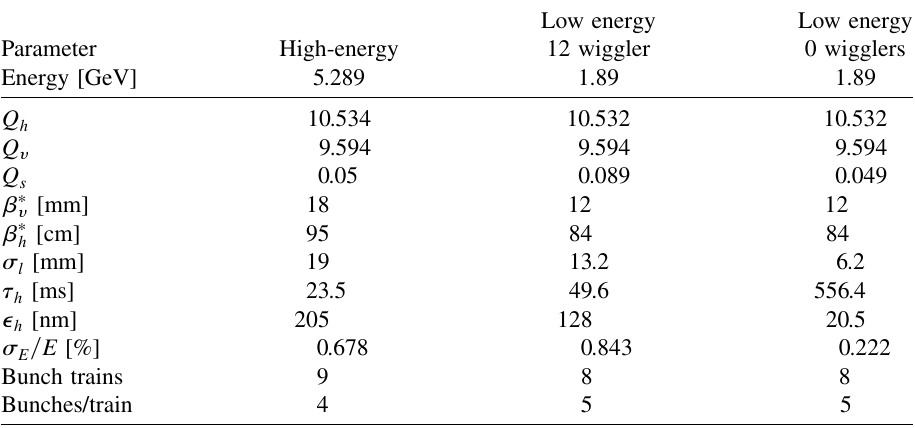
TABLE I. Parameters of high-energy optics, low energy optics with 12 2.1 T wigglers and low energy optics with no damping